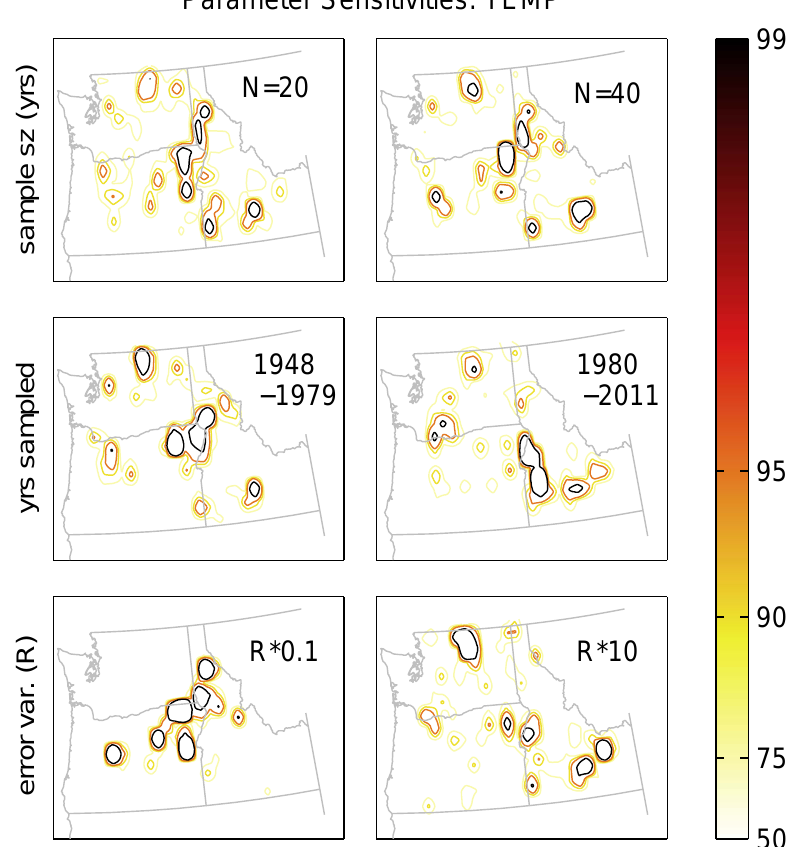
Fig. 4. Sensitivity of network design results for annual temperature, obtained by varying the parameters used to apply the algorithm. The top row shows results in which the sample size is varied between 20 and 40yr, the middle row shows results obtained from the first half of the record (1948–1979) and the last half (1980–2011), and the bottom row shows the impact of scaling the measurement error ( R 2 ) by an order of magnitude in each